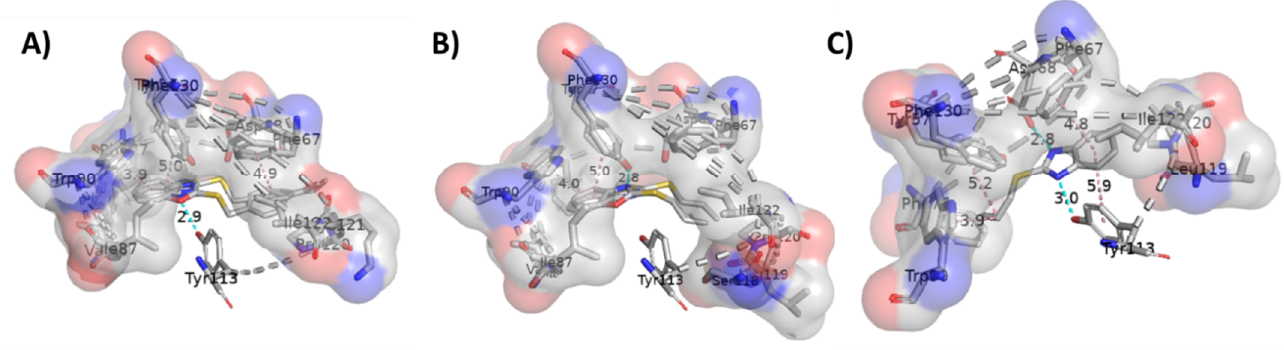
Figure 4. Interactions maps between receptor mTOR and molecules ( A ) BTA-1 , BZM-2 , and BOX-3 ; ( B ) BTA-4 and BOX-6 ; ( C ) BZM-5 cyan dashed lines represent hydrogen bonds, and pink lines represent pi–pi stacking interactions.